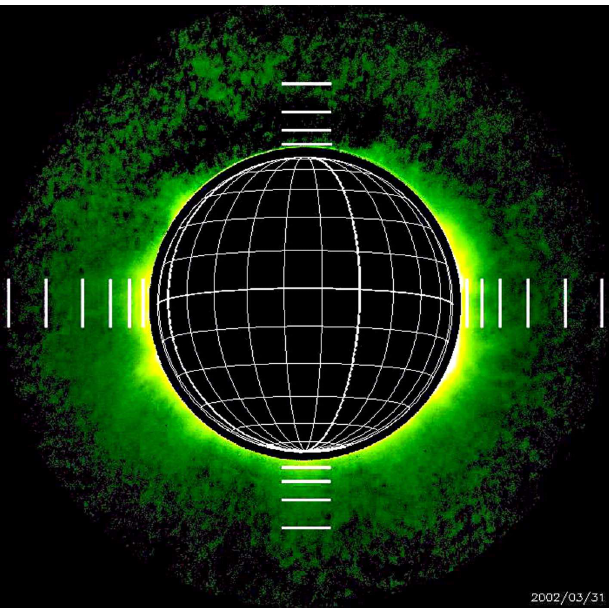
Fig. 1. A reconstructed image of the Fe XIV corona made from the series of observations with the MICA coronagraph in Argentina (see Stenborg et al., 1999). The positions and lengths of the entrance slit of our spectrograph are indicated (see also Table 1). The MICA image is a processed average of the best frames taken during the whole duration of our observations on 31 March 2002. Note the absence of a significant signal above the North Pole, which is a result of both the weak level of Fe XIV line emission and possibly of a slightly exaggerated cancellation of the (fluctuating)